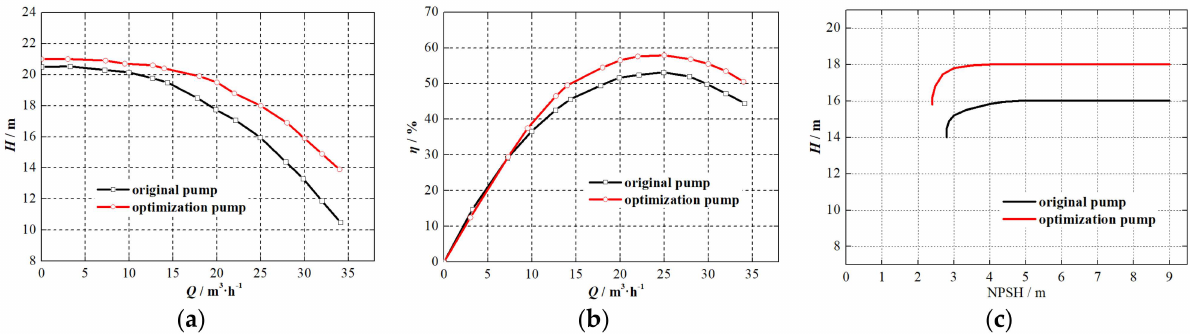
Figure 22. Tested performance comparison between pumps before and after GA_PSO optimization. ( a ) H - Q curve. ( b ) η - Q curve. ( c ) cavitation